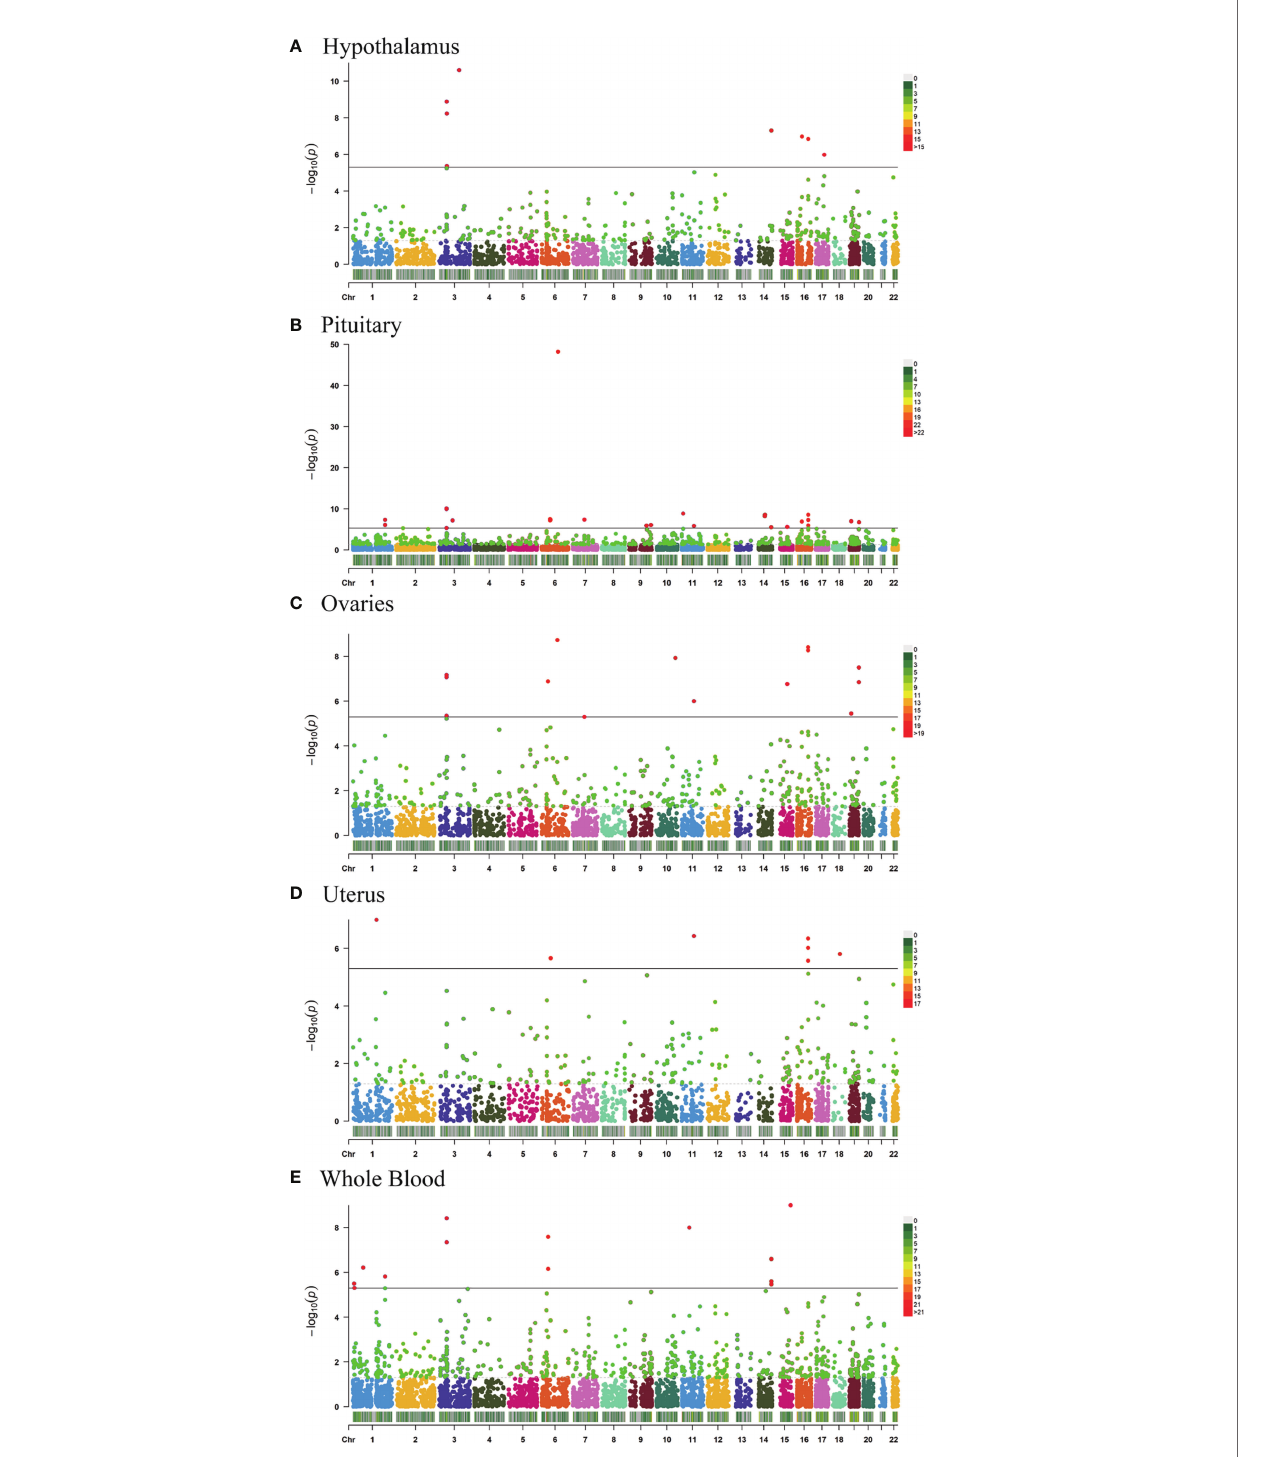
FIGURE 1 | Manhattan plots of the association results from the AAM TWAS. The dashed horizontal lines represent P = 5.00 × 10 − 2 . The solid horizontal lines represent P = 5.00 × 10 − 6 (Bonferroni correction). Each dot represents the genetically predicted expression of one speci fi c gene in the hypothalamus, pituitary gland, ovary, uterus, and whole blood tissues. The X axis represents the chromosome (Chr) encoding the corresponding gene, and the Y axis represents the negative logarithm of the association P TWAS value. (A) Gene-expression weights for the hypothalamus. (B) Gene-expression weights for the pituitary gland. (C) Gene-expression weights for the ovaries. (D) Gene-expression weights for the uterus. (E) Gene-expression weights for whole